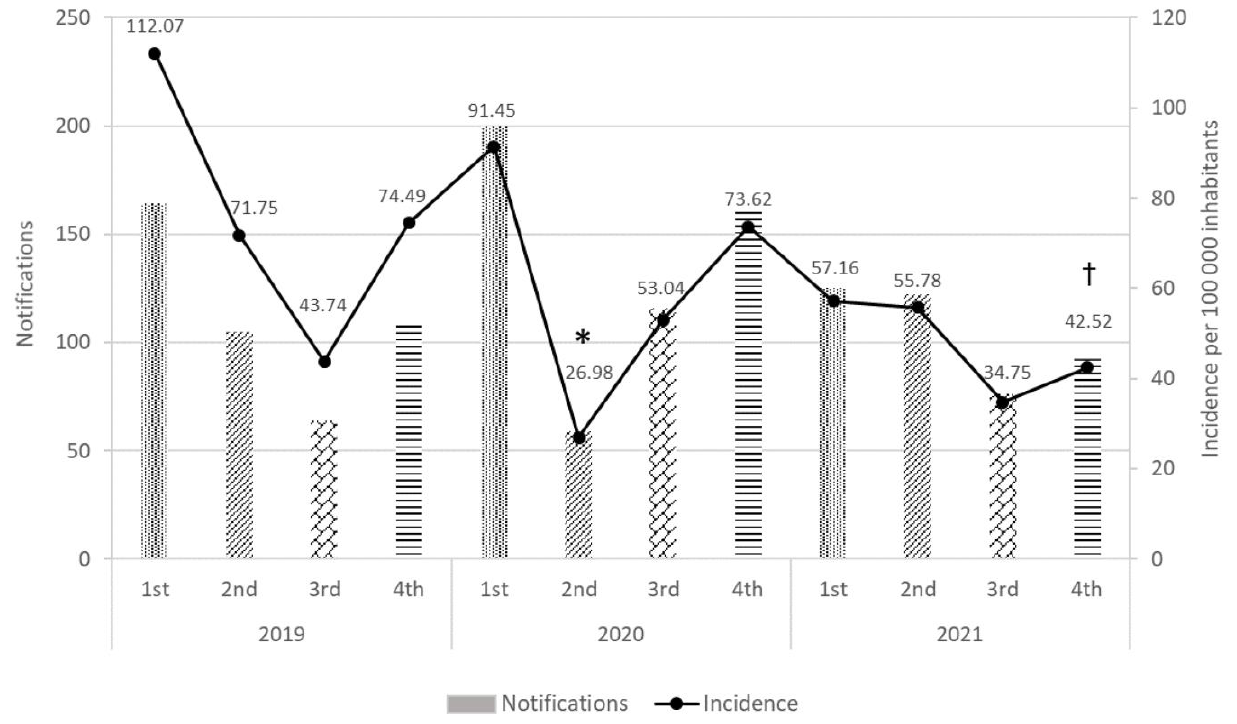
Figure 1. Number of ME notifications and incidence rates per quarter (Catalonia, 2019–2021). Significant differences in incidence: * vs. second quarter of 2019, † vs. fourth quarter of 2019 ( p < 0.05).